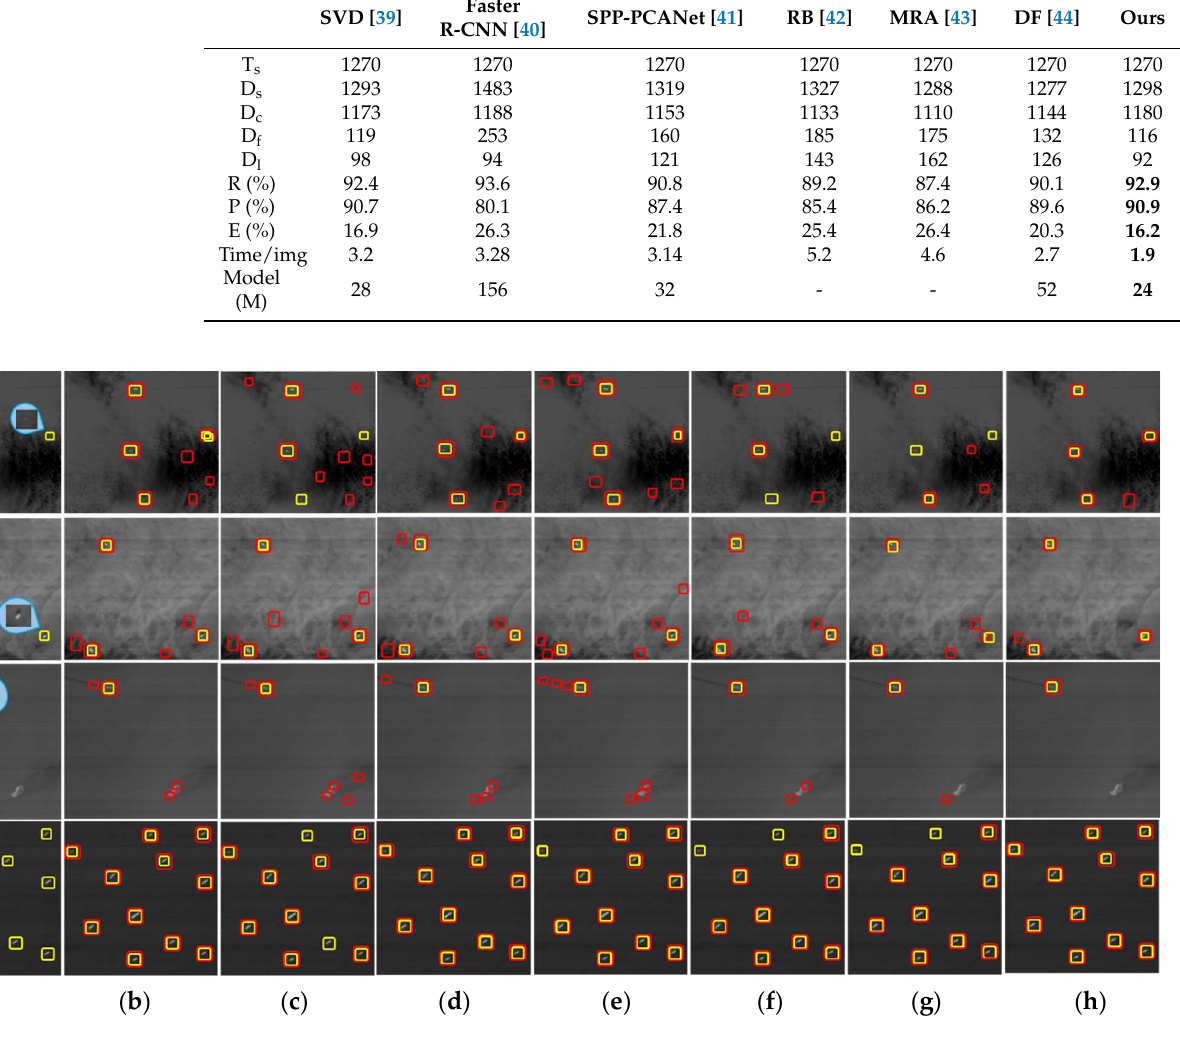
Figure 8. Detection results for various methods. ( a ) Real target in the original image, ( b ) SVD, ( c ) Faster R-CNN, ( d ) SPP-PCANet, ( e ) RB, ( f ) MRA, ( g ) DF, and ( h ) our method.